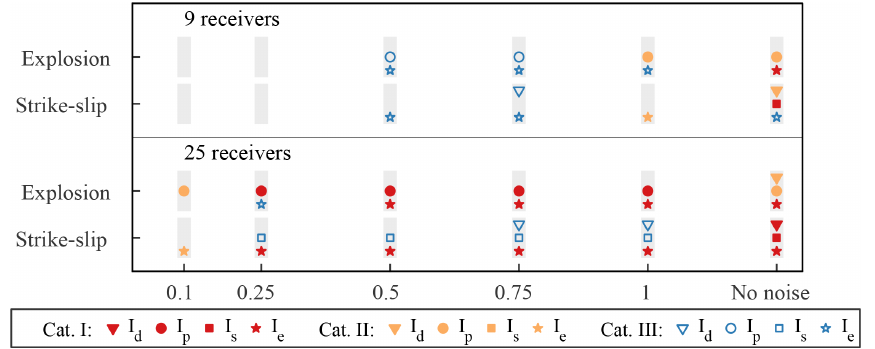
Figure 13. The location accuracy obtained with different amounts of noise added to the traces. A set of 9 receivers and a set of 25 receivers was tested for two different source types. The locations obtained with the individual imaging conditions were ranked according to the categories from Fig. 2. Grey bars indicate set-ups that were tested. No symbol in the grey bar means the localisation was unsuccessful. Symbol types and colours in the grey bars represent successful locations with the imaging condition sorted into the respective category.